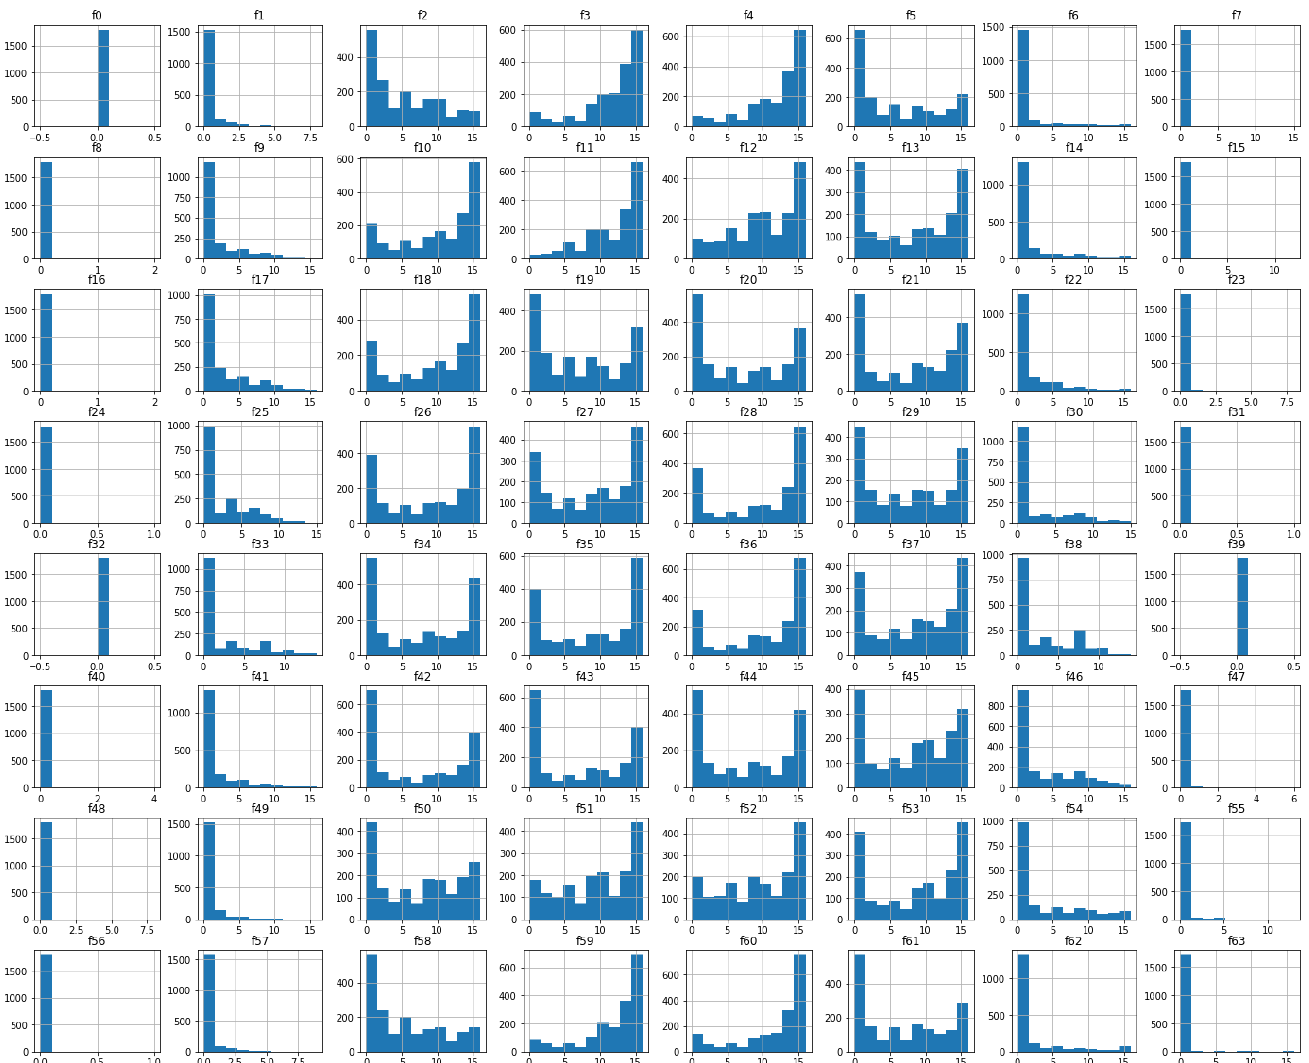
Figure 3. Feature distribution of the original